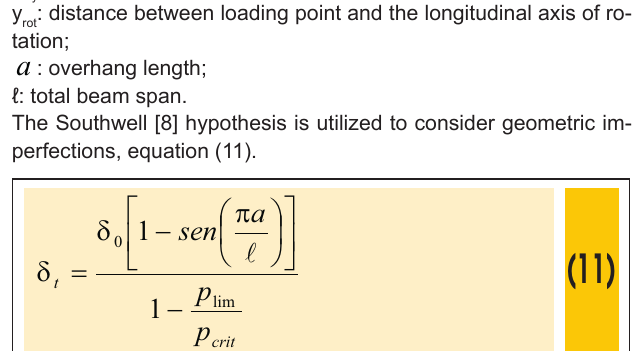
Figure 2 – Lateral displacement and twist rotation of the